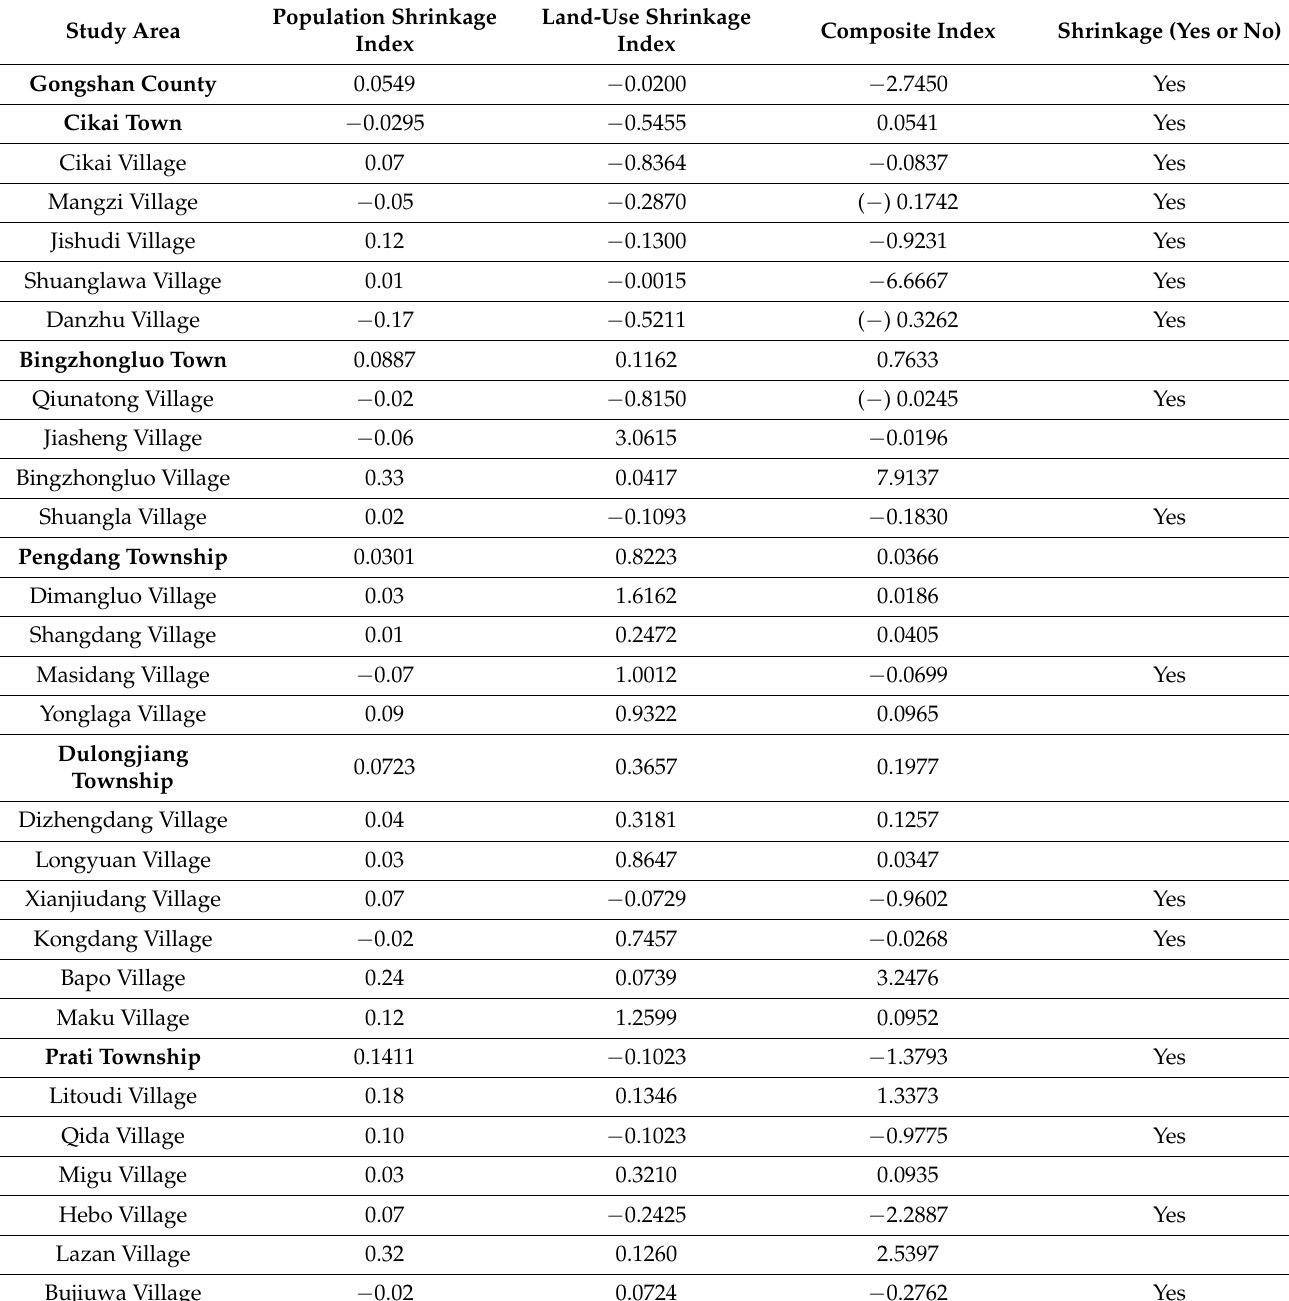
Table 1. Measurement results for population- and land-contraction values at three